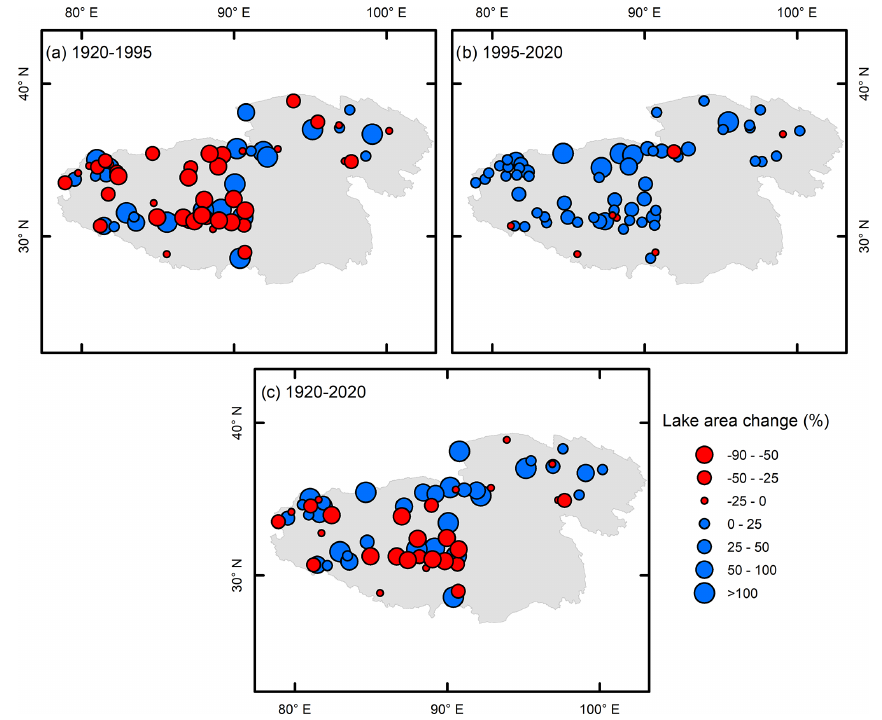
Figure 9. Spatial patterns of lake area changes during different evolution stages. (a) 1920–1995. (b) 1995–2020. (c) 1920–2020.